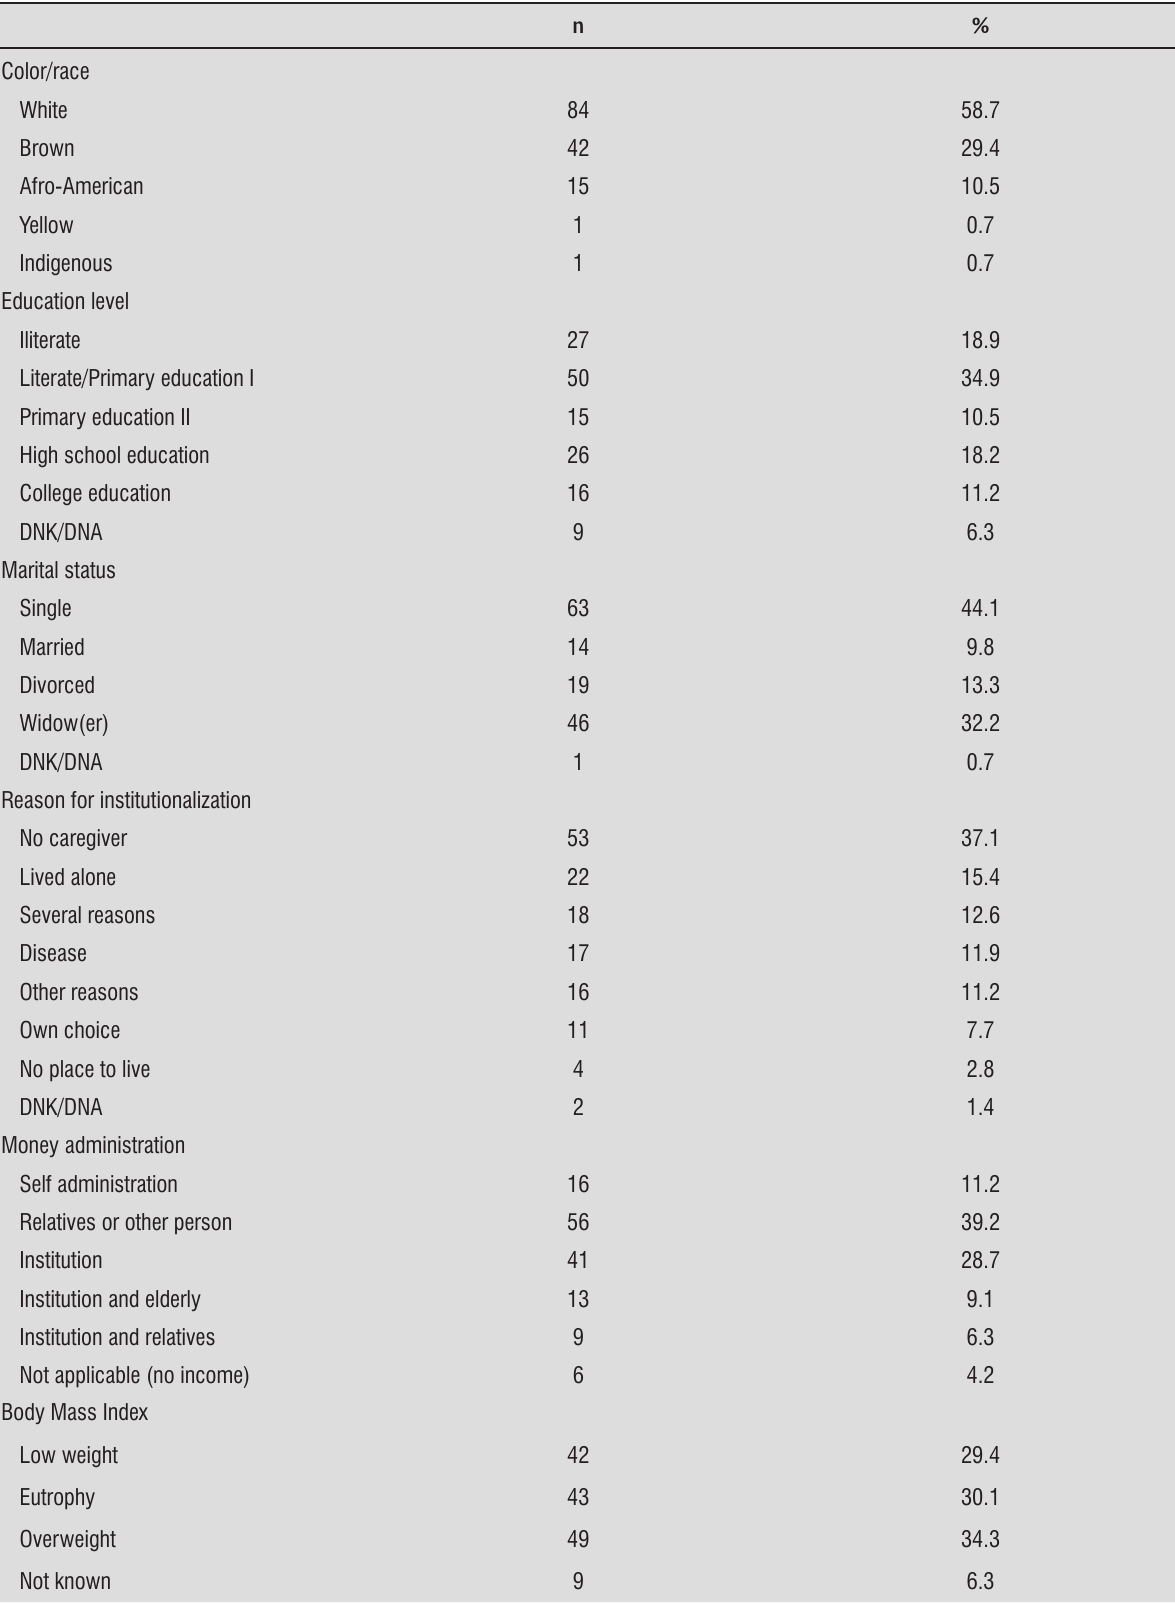
Table 1 - Socio-demographical and health-related information – Natal (RN),